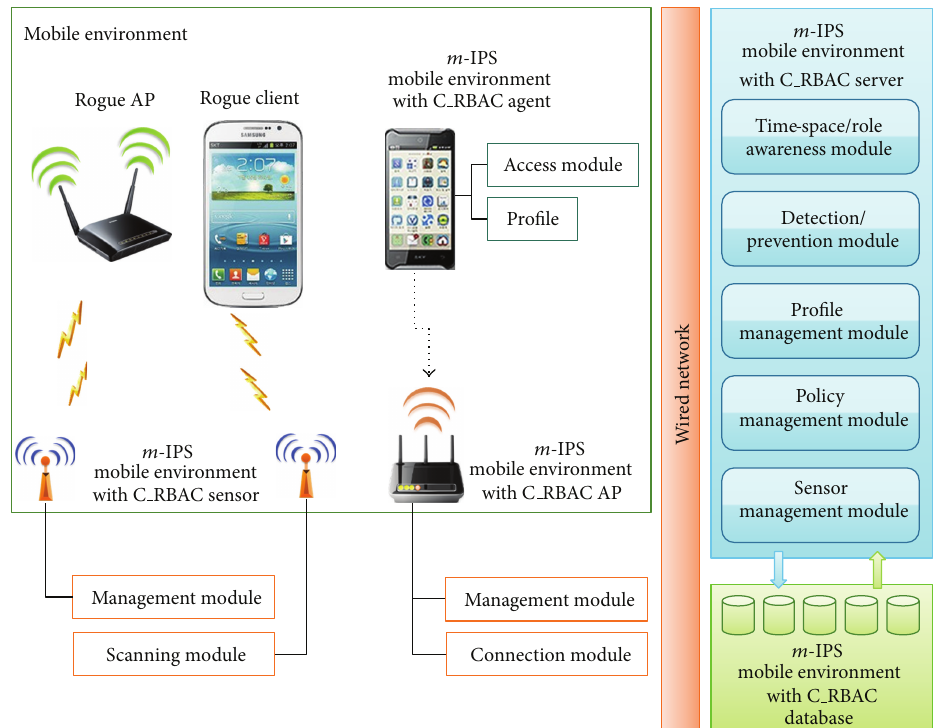
Figure 2: m- IPS for mobile environment with temporal-spatial awareness-RBAC (TA-RBAC)